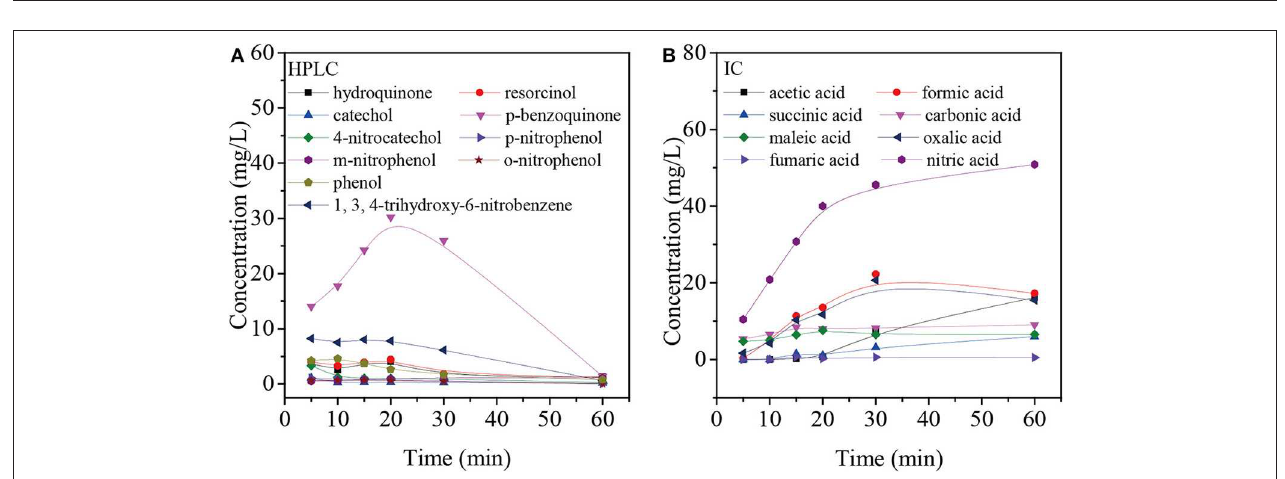
FIGURE 8 | Intermediate products based on HPLC (A) and IC (B) from the degradation of nitrobenzene using COP with Mn-USY.